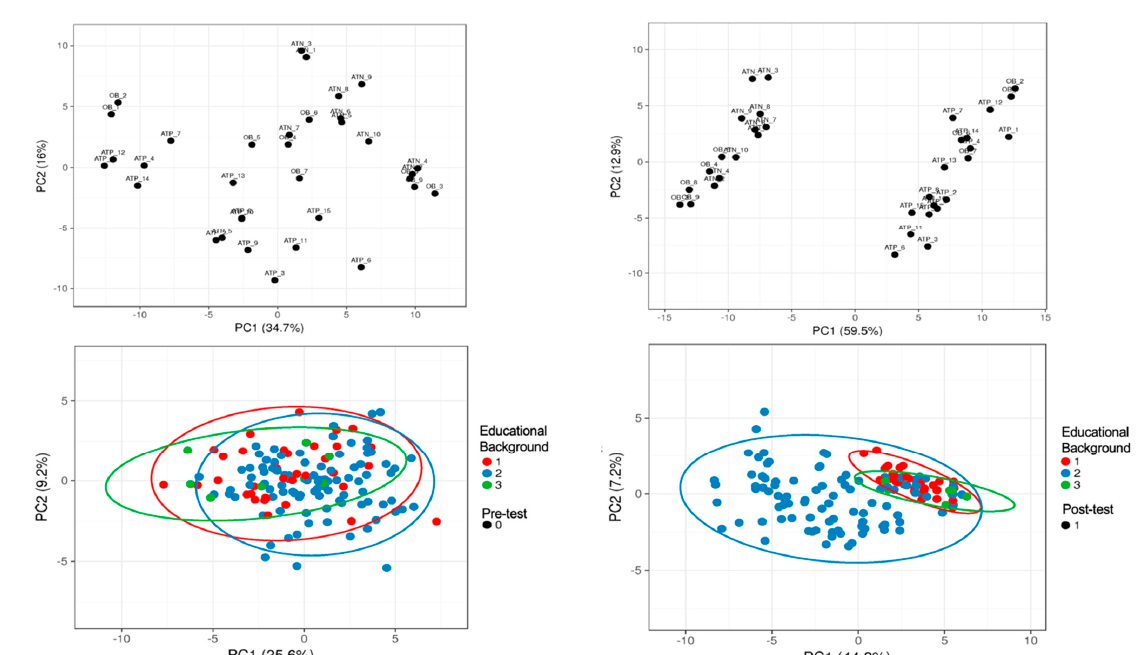
Figure 7. The principal component analysis (PCA) diagram, X and Y axis show principal component 1 and principal component 2 for the pre- ( left ) and post-test ( right ) data set. The explained variance is indicated in each plot axis. Ellipses and shapes in the score plots show the clustering of the sample at a 0.95 confidence level.